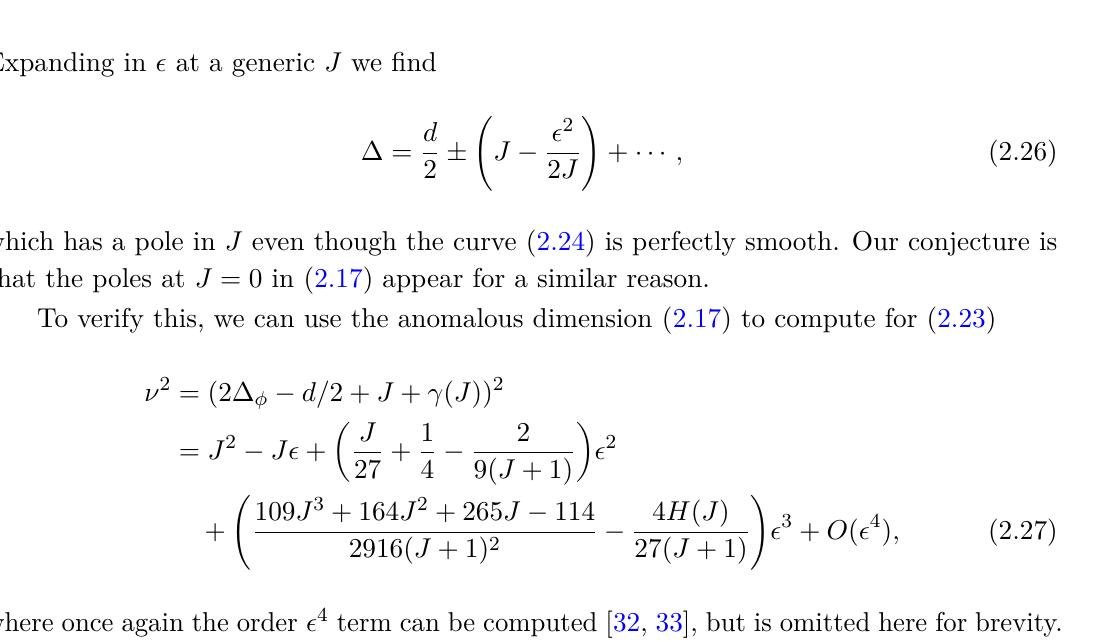
Figure 5. Chew-Frautschi plot of the leading Regge trajectory in Wilson-Fisher theory near the intercept at O ( (cid:15) 4 ) (solid, blue). Free theory trajectories are shown in dashed red. The plot is made at (cid:15) = 0 . 3 . See also figure